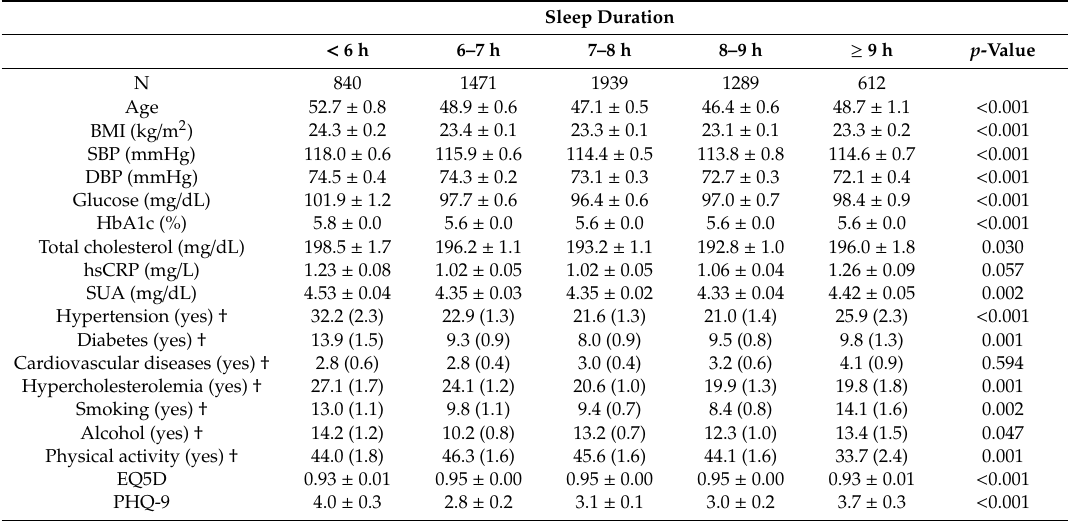
Table 1. General characteristics of the study population according to sleep